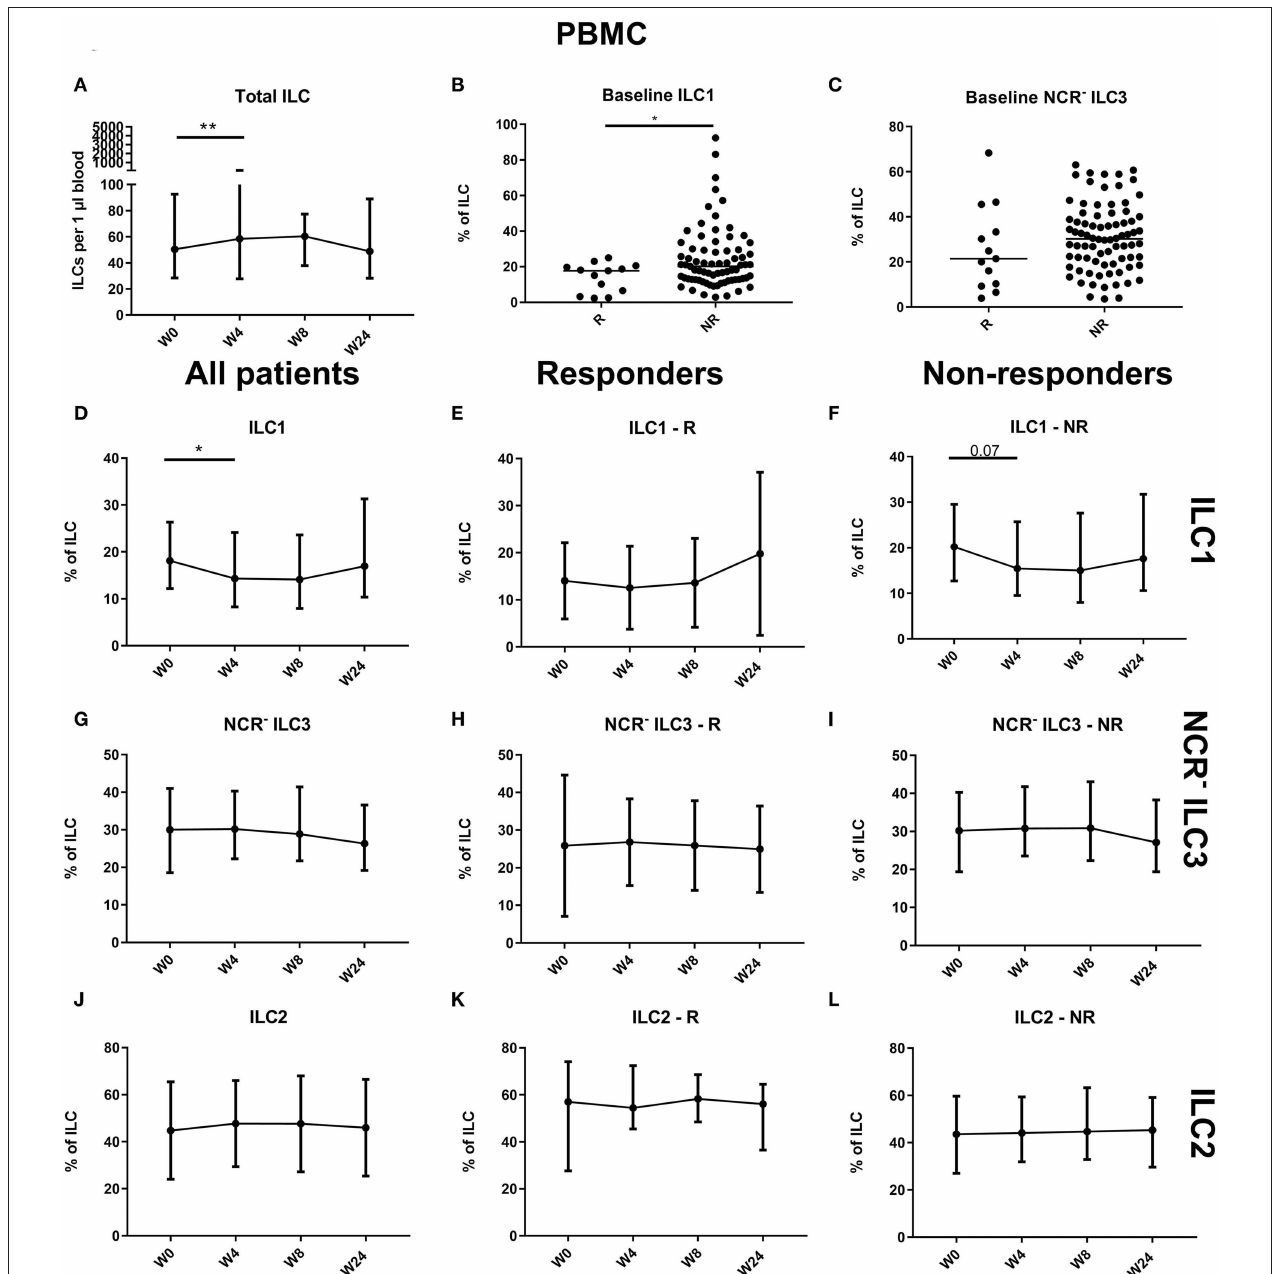
FIGURE 4 | Follow-up of circulating ILC during ustekinumab treatment. Eighty-five patients initiating ustekinumab treatment were followed up for 24 weeks. Blood was collected at weeks 0, 4, 8 and 24. Patients were subdivided into responders (R, n = 15) and nonresponders (NR, n = 70) based on endoscopic evaluation. Total ILC proportion expressed as cells per microliter of blood in all patients (A) . Baseline ILC1 (B) and NCR − ILC3 (C) levels expressed as proportion of ILC in R and NR. Follow-up of circulating ILC1 in all patients (D) , R (E) and NR (F) . Follow-up of circulating NCR − ILC3 in all patients (G) , R (H) and NR (I) . Follow-up of circulating ILC2 in all patients (J) , R (K) and NR (L) . Mann–Whitney U testing (B,C) ; Wilcoxon paired-match testing (A,D–L) ; * p < 0.05, ** p ≤ 0.01. NCR, natural cytotoxic receptor; ILC, innate lymphoid